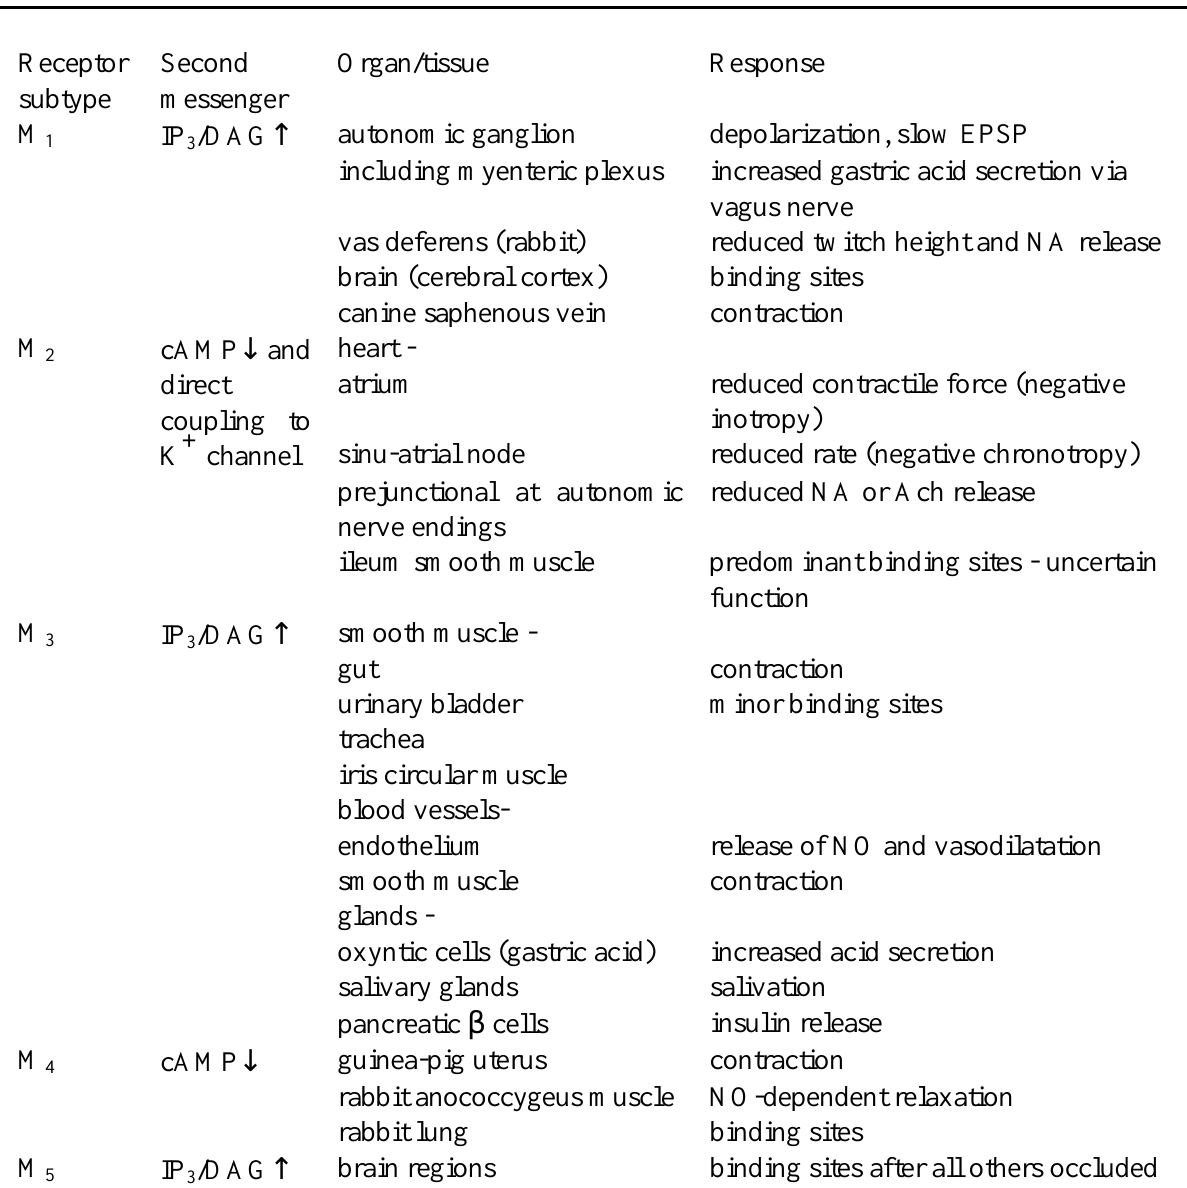
Table 1. Muscarinic receptors, second messengers and tissue responses